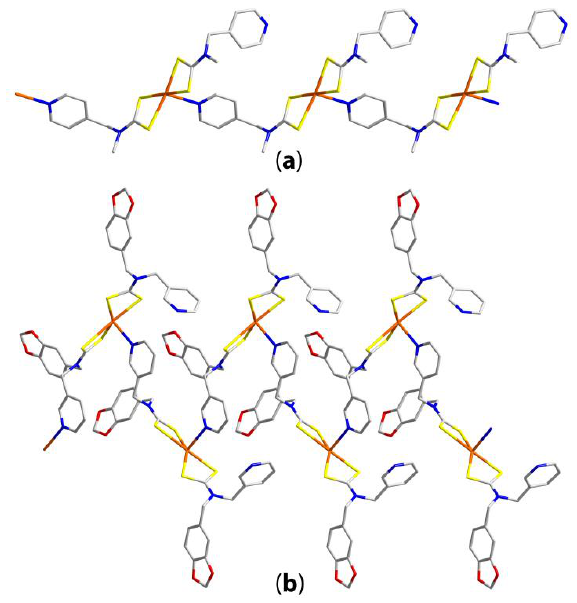
Figure 16. One-dimensional aggregation in ( a ) {Hg[S 2 CN(Me)CH 2 (4-py)] 2 } n ( 181 ) and ( b ) [Hg{S 2 CN[CH 2 (4-py)]CH 2 (1,3-benzodioxo-5-yl)} 2 ] n ( 182 ). In {Hg[S 2 CN[CH 2 (4-py)]CH 2 (2-furyl)] 2 } n ( 183 ) [72], both pyridyl-nitrogen atoms are involved in